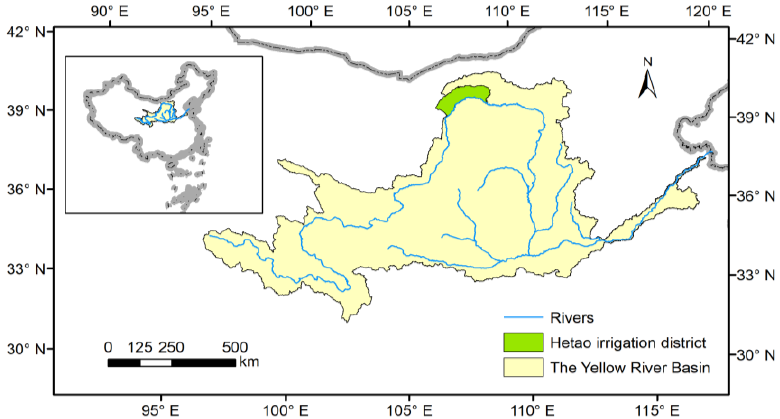
Figure 1. The Yellow River basin and location of the study area, Hetao irrigation district (HID).